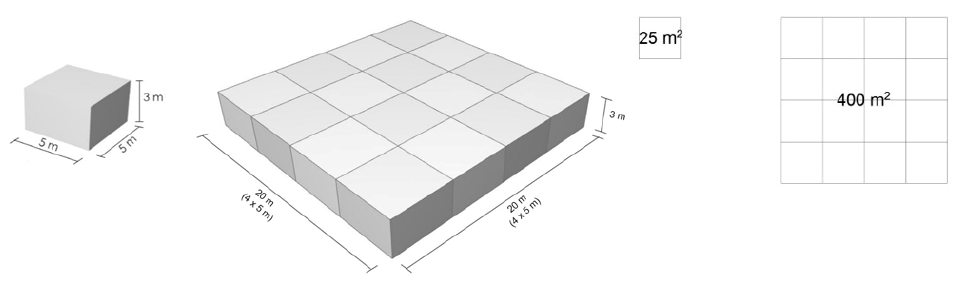
Figure 1. Basic unit (BU) and basic group (BG).